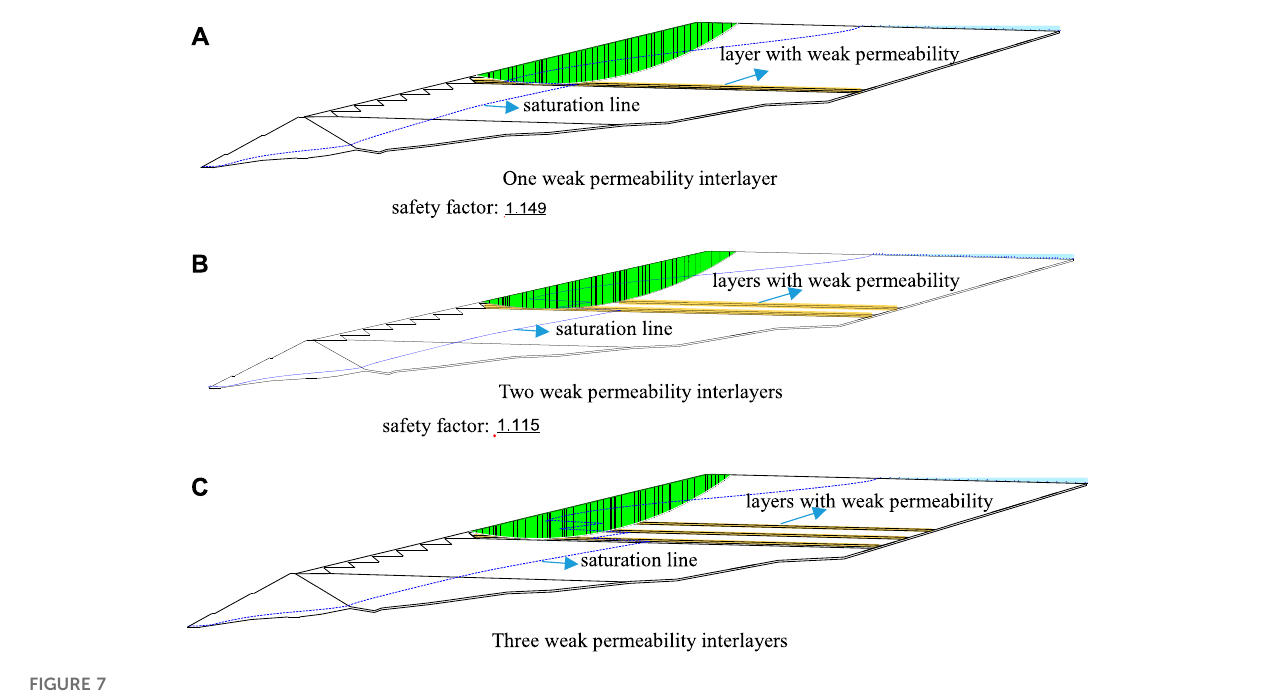
FIGURE 7 The curve of the number of low-permeability layers and safety factor. (A) One weak permeability interlayer. (B) Two weak permeability interlayers. (C) Three weak permeability interlayers.